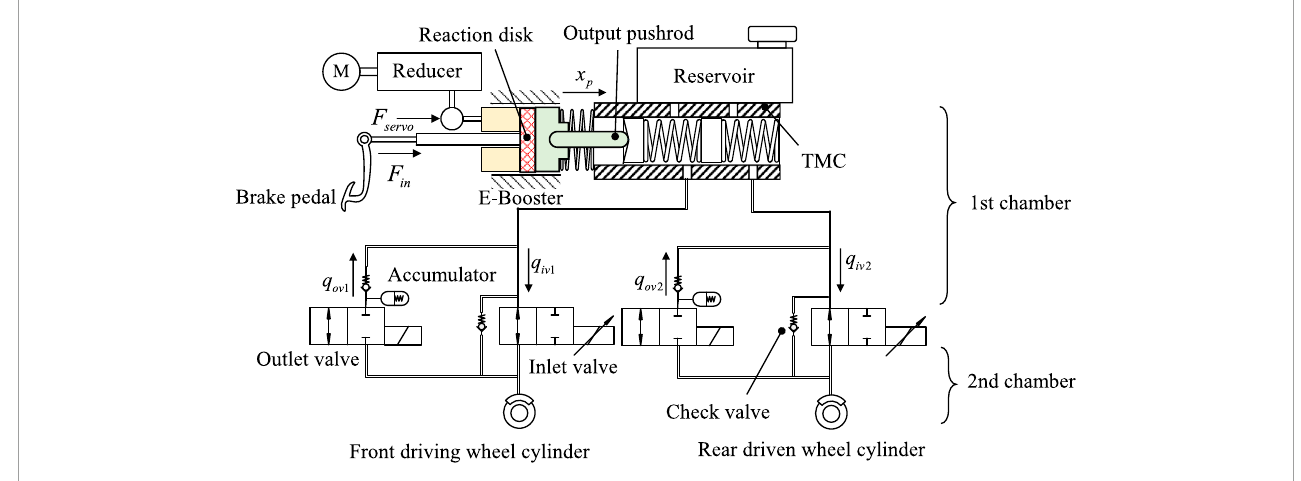
FIGURE 1 Simplified schematic diagram of the electro-hydraulic system.